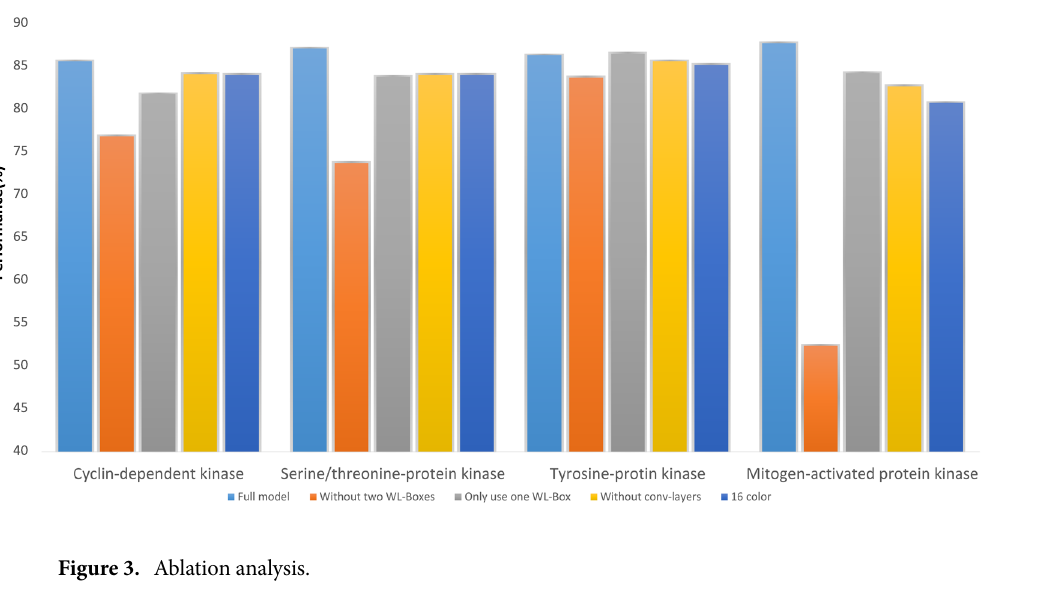
Figure 3. Ablation